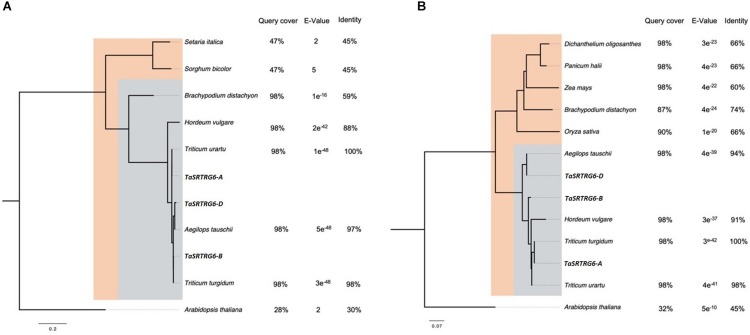
Neighbor-joining phylogenetic trees showing the taxonomic distribution of two taxonomically restricted Septoria responsive genes (TaSRTRGs). Trees are rooted by the top BLASTx hit from the Arabidopsis thaliana genome. Orthologs from other species were identified via BLASTx search of the TaSRTRG A homoeolog sequence to the NCBI protein database. (A)
TaSRTRG6 is restricted to the Pooideae subfamily (blue box), with weak homology to species outside of the Pooideae but within the Poaceae family (orange box). (B)
TaSRTRG7 is found in species from within the Pooideae (blue box) and the Poaceae (orange box). TaSRTRG7 was not found in any species outside of the Poaceae.